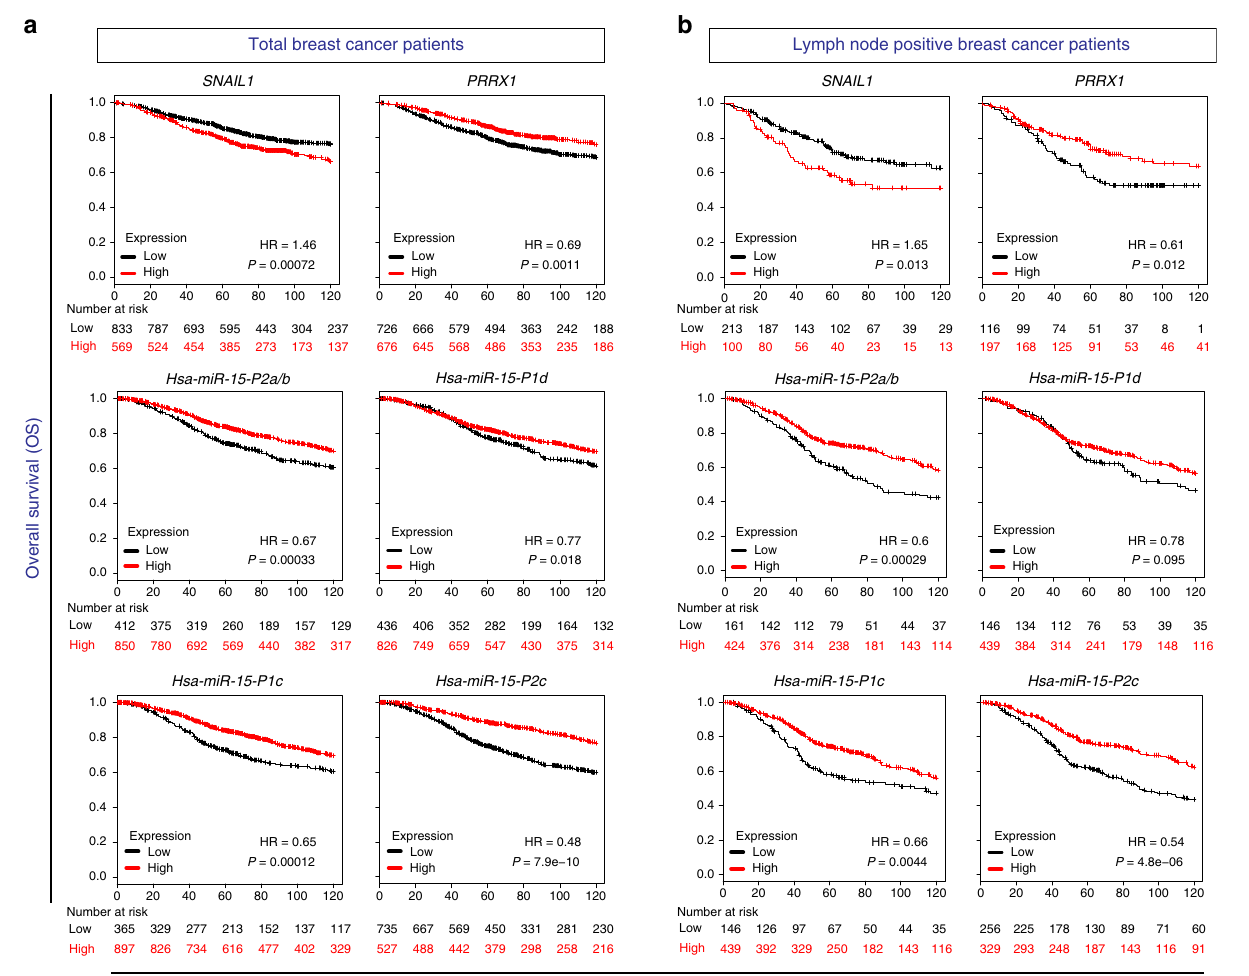
Fig. 5 Relationship between the expression of SNAIL1 , PRRX1 , and miR-15 family members and overall survival in breast cancer patients. Kaplan – Meier overall survival (OS) plots from breast cancer patients with lymph-node positive status, showing that high expression of SNAIL1 correlates with low survival, while PRRX1 high expression correlates with a better survival. The expression of miR-15 family members follow a similar trend as that of PRRX1 . Hazard ratio (HR) and logarithmic ranked p Value (longrank P ) were analyzed to infer the signi fi cance of the differences. Numbers below each graph represent number of patients at risk in any given time (months), black for low expression and red for high expression of each gene/miRNA. The cut-off is automatically calculated based on the best performing